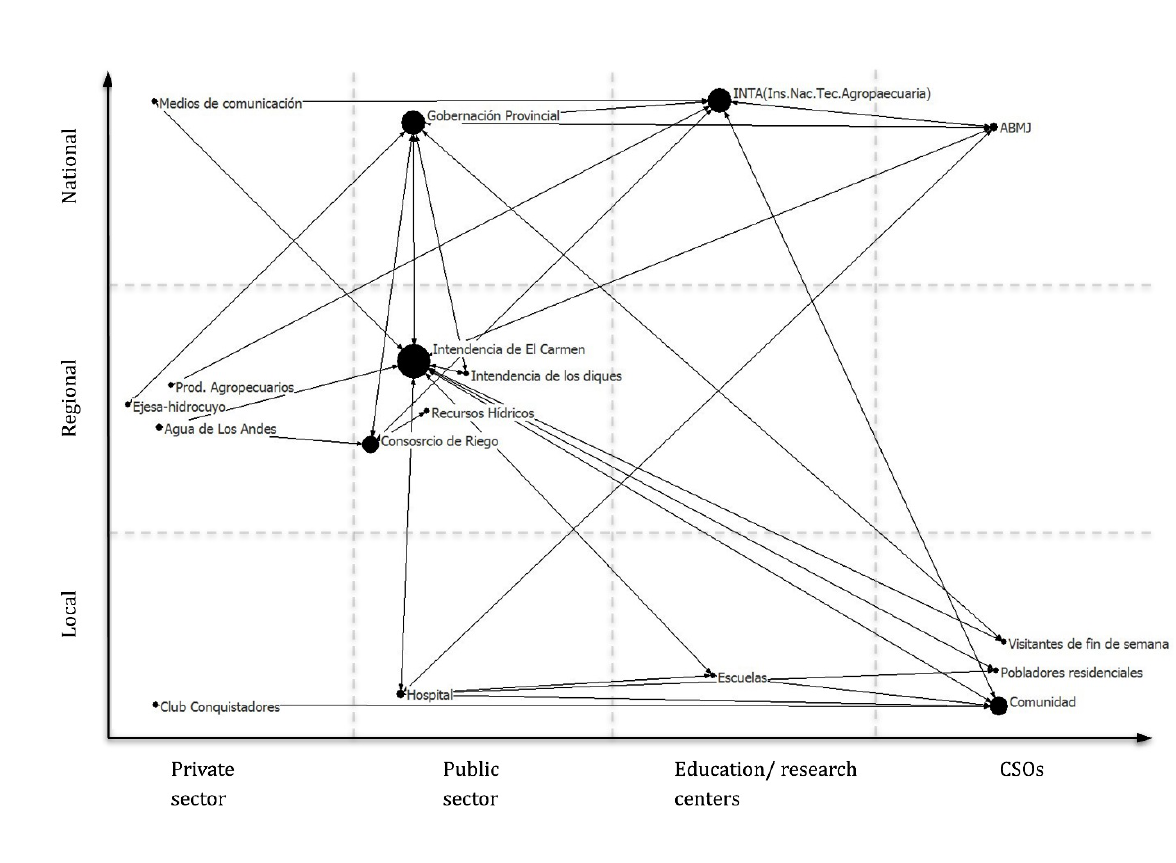
Fig. A2.1. Water governance network from the perspective of representatives of local public entities in the Jujuy Model Forest (JMF), Argentina. The actor nodes in the networks represent organizations and social groups perceived as relevant to water resources management. The x-­‐axis categorizes the actor nodes according to the sector they relate to. Civil society organizations (CSOs) include non-­‐ governmental organizations. The y-­‐axis categorizes actor nodes by their scale of action. The local scale relates to the pilot area in the JMF, the regional scale corresponds to the model forest landscape, and the national scale represents Argentina. Actor node size relates to inbetweenness centrality, which corresponds to the importance of the node as bridge in the network. See Appendix 3 for a list of the main actors and the role they play in the water governance network according to participants’